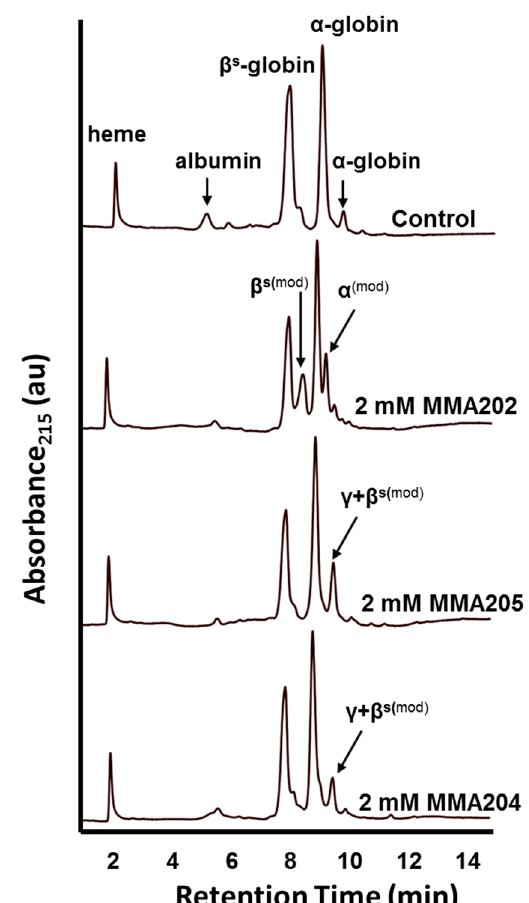
Figure 6. Reverse-phase HPLC of 0 mM (control) and 2 mM of MMA-202, MMA-204, and MMA-205 after incubation with intact SS cells. Identities of modified peaks were assigned based on the balance between α and β -like ( β and γ globin) chains.